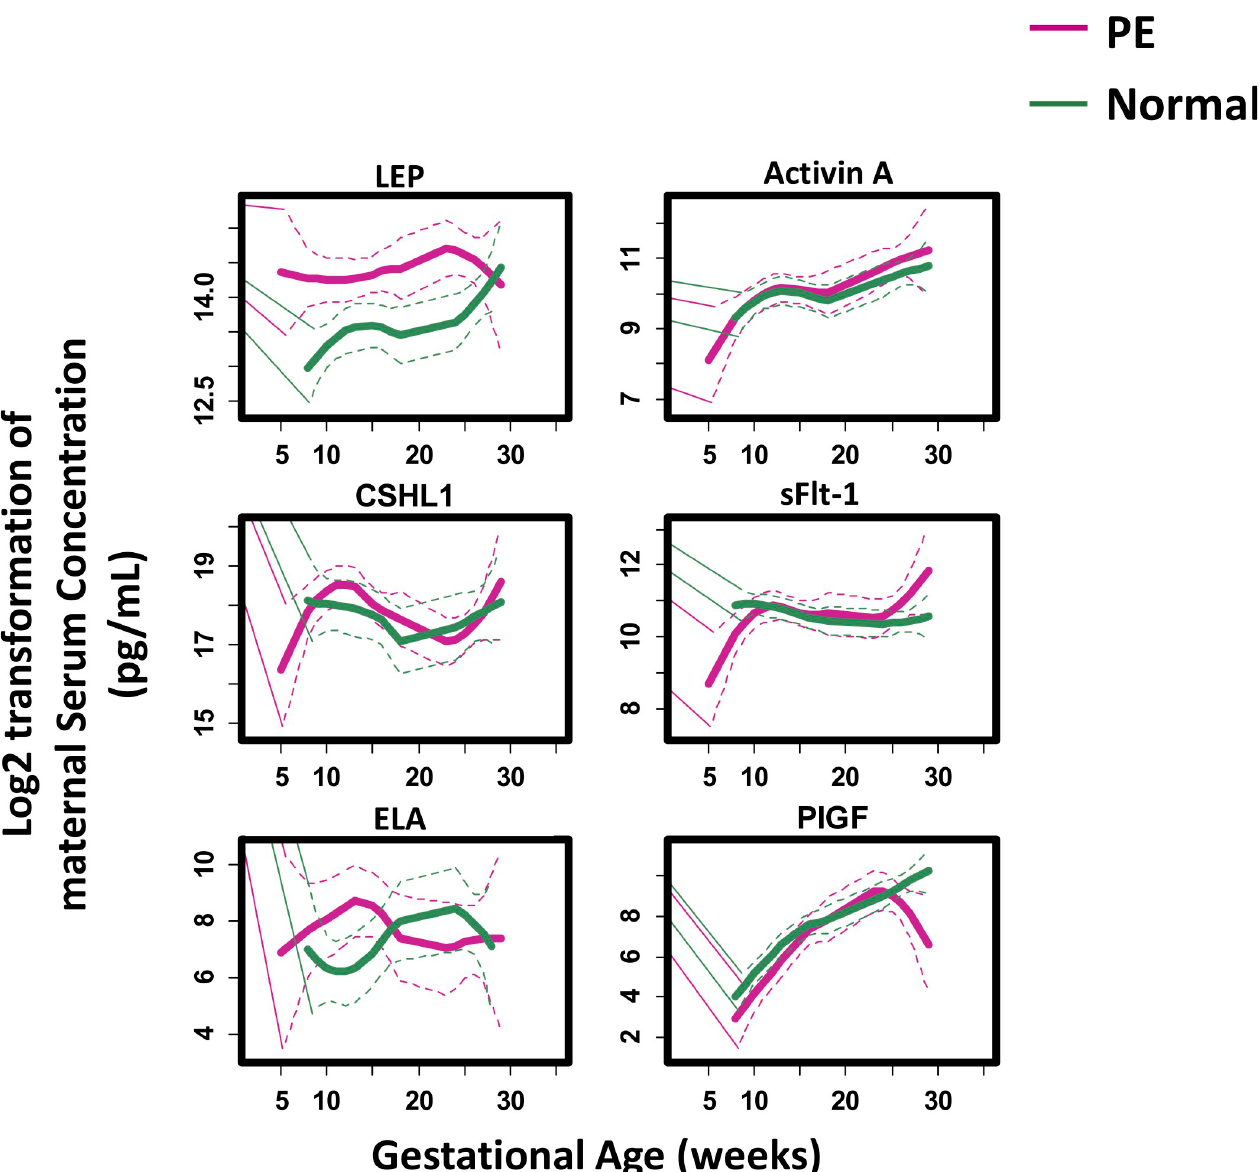
Fig 3. Maternal serum concentrations of the 6 studied placenta-related proteins plotted as a function of GA. Loess smooth function was applied to demonstrate the trend of the proteins in normal term (green line) and PE (red line) pregnancies, respectively. Color-matched dotted lines show the 95% confidence interval for each